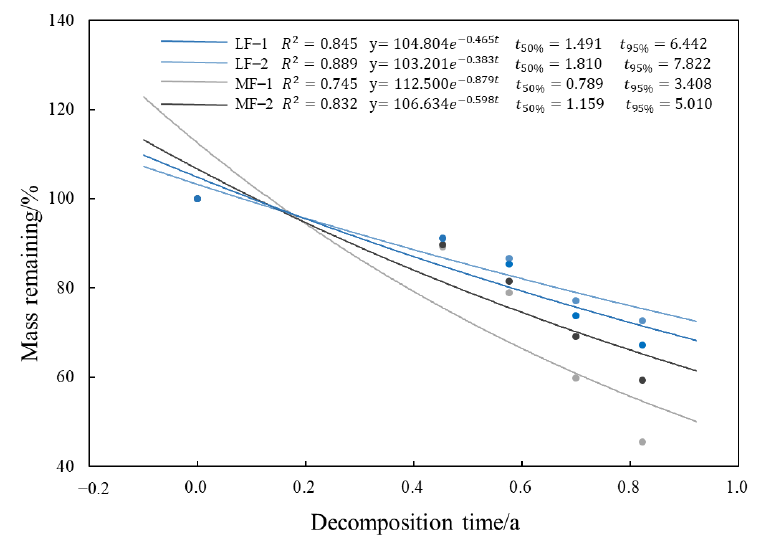
Figure 7. Olson negative index regression relation between litter residues and time.